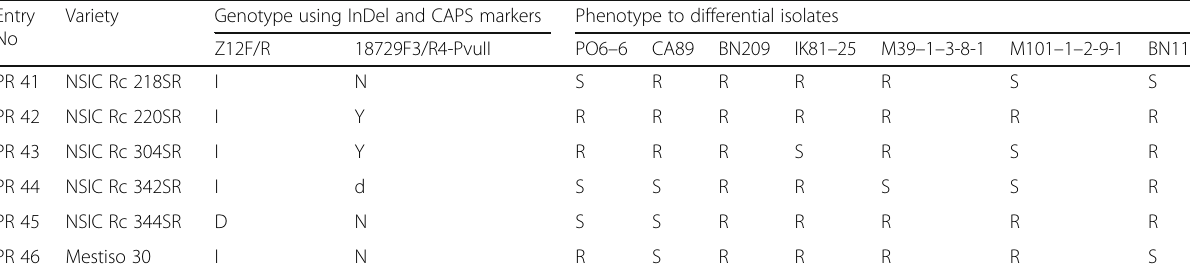
Table 5 Genotype and phenotype of IRRI new released varieties (Continued) Variety Genotype using InDel and CAPS